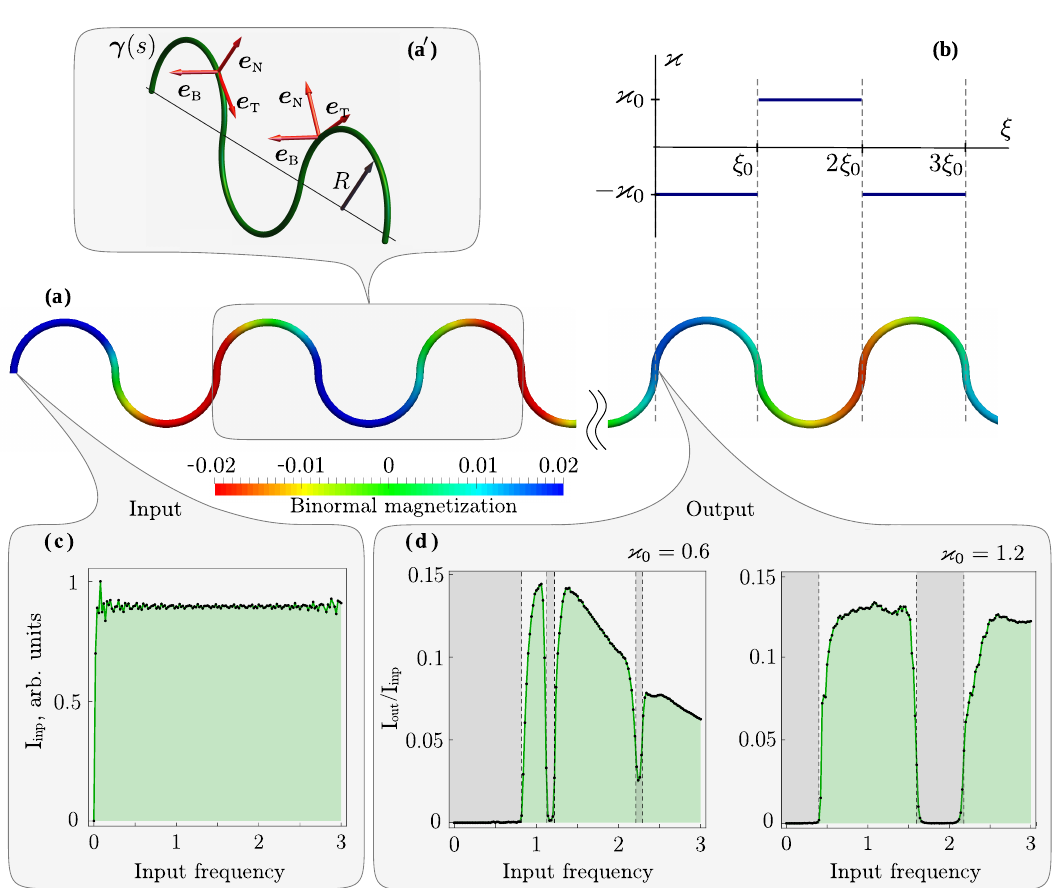
Figure 1: Meander-like shape nanowire: Wire in form of periodically repeated semicircles (a),(a (cid:48) ) has the square-wave curvature (cid:99) ( ξ ) (b) with dimensionless am- = (cid:96)/ R and period 2 ξ = 2 π/ (cid:99) plitude (cid:99) . We demonstrate that the considered 0 0 0 meander-like shape structure can be used as a magnon filter element using spin- lattice simulation based on Landau–Lifshitz equation with damping, for details see Appendix C.2. Colour scheme shows the binormal magnetization distribution in the = 1.2 and input signal of dimensionless frequency Ω = 1. wire (a) with curvature (cid:99) 0 Amplitude-frequency characteristics of input (c) and output (d) signals of a magnon filter element is composed of 14 periods of the meander shaped structure. The fre- quency ranges, where the magnons propagation is strongly depressed are shown by the grey shading. The band gaps position and width can be controlled by the pa- rameter (cid:99) . Decreasing the output amplitude with frequency takes place due to the 0 natural damping ( α = 0.01) included into the simulations. The terminator is placed after a magnon filter element to prevent signal reflection from the free boundary of the system. The terminator is composed of 5 periods of the meander shaped struc- ture and has a spatially increasing damping coefficient, see Appendix C.2 for details. The magnetization dynamics is illustrated at the Supplemental movie 1